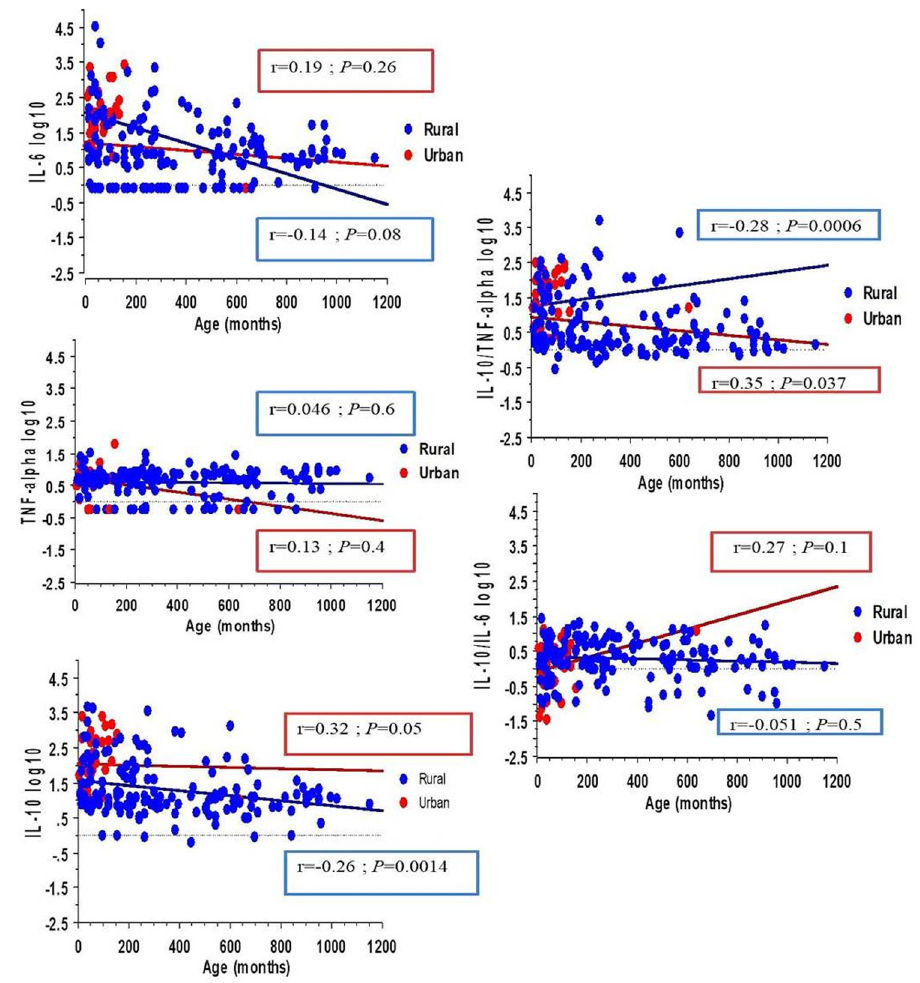
Fig 3. Cytokines profiles stratified by areas according to age in months. IL-10 level decreased when age increased in rural area. IL-10/TNF-alpha ratio increased with age in rural area but decreased in urban area.